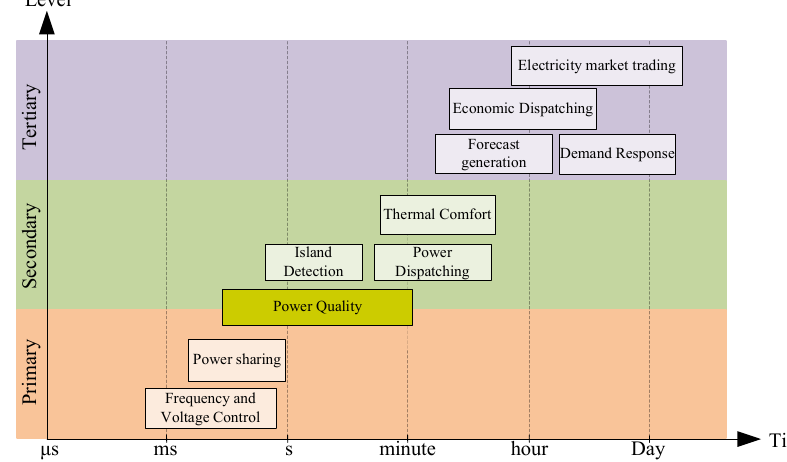
Figure 5. Timeline of the execution of main control algorithms in microgrids.